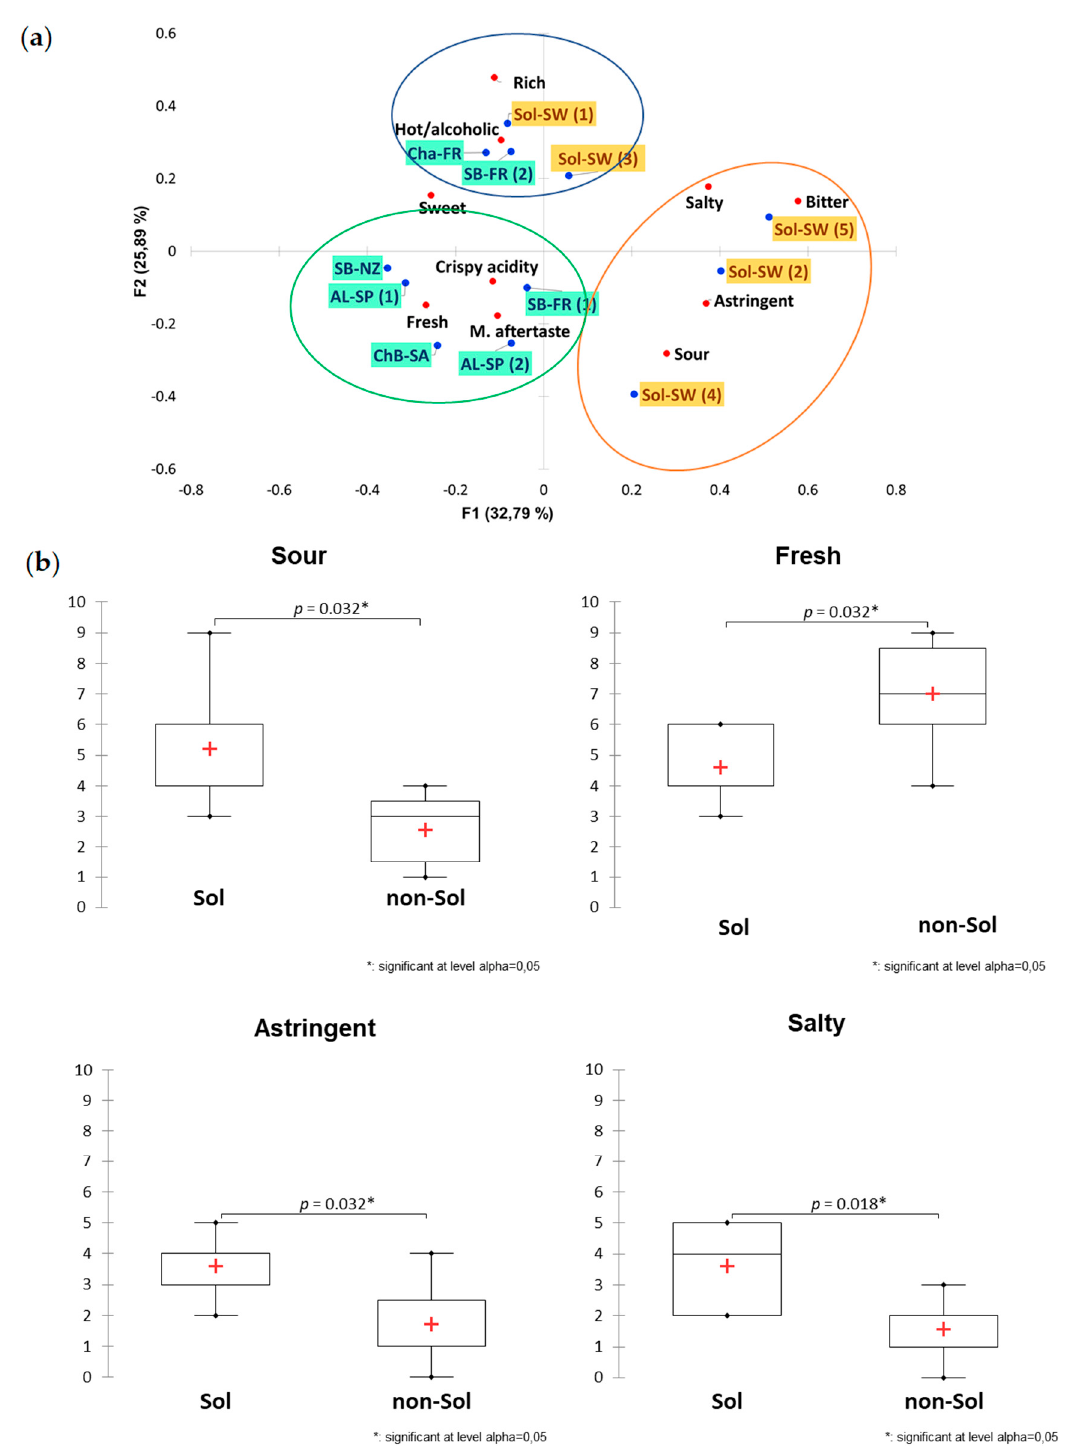
Figure 3. ( a ) CA biplot representing the distribution of the wines according to the frequency of citation of all the provided taste and mouth-feel descriptors. Circles represent the clusters found with the corresponding HCA analysis. ( b ) Box-and-whiskers plots illustrating the taste and mouthfeel attributes significantly different between Sol and non-Solaris wines based on a Student t-test.